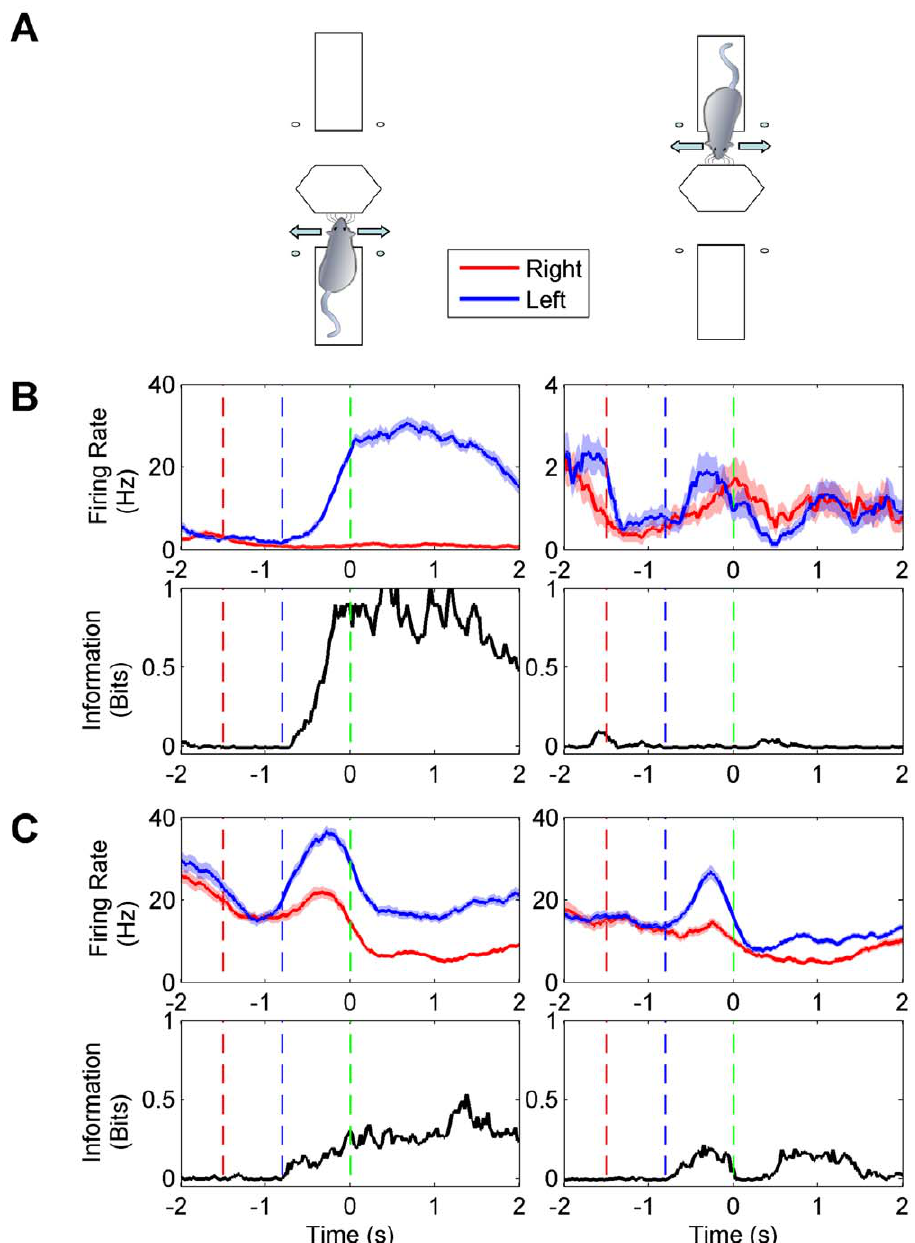
Figure 4. Representation of reward location. (A) The icon on the left indicates a platform A position: corresponding neuronal data are in the left panels of (B) and (C). The icon on the right indicates a platform B position: corresponding neuronal data are in the right panels of (B) and (C). (B) Neuron representing reward location on platform A (left) but not on platform B (right). Upper plots – time-varying firing rates aligned on the moment of reward delivery. Lower plots – temporal profiles of reward location information. In all response profiles, shaded area corresponds to standard error of the mean. Red, blue, and green dashed lines indicate the estimated start of time windows during which rats engaged in touch, turn and reward collection. (C) Neuron representing reward location on both platforms A and B, but with different strength and firing rates. The neurons illustrated in (B) and (C) did not encode texture.